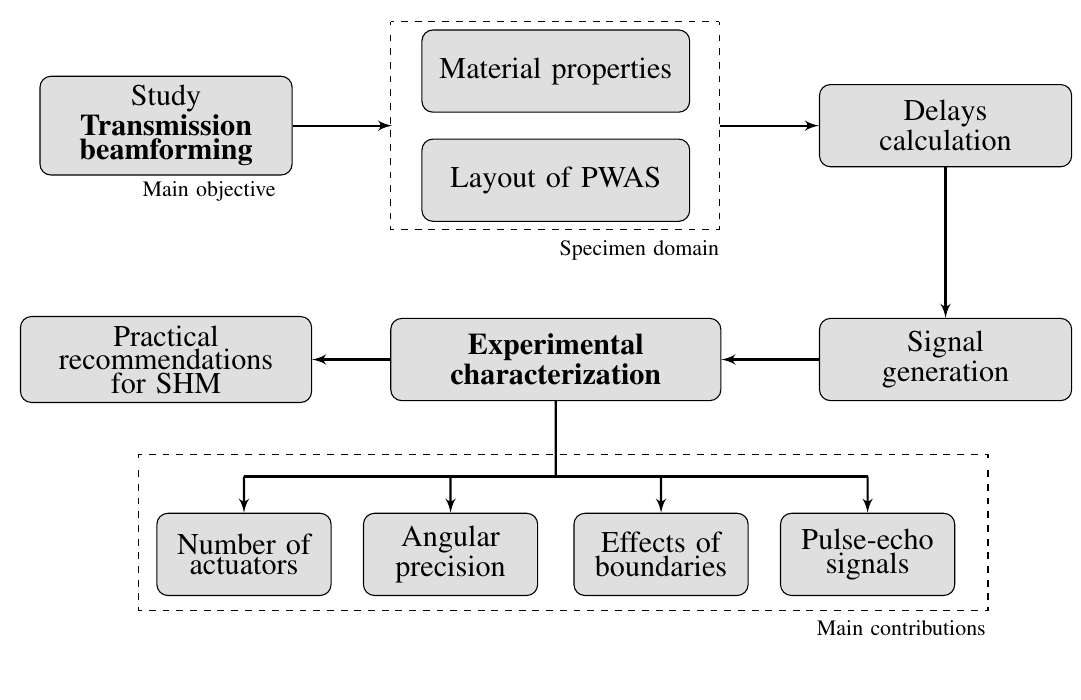
Figure 1. Main objective, contributions, and methodology proposed in this